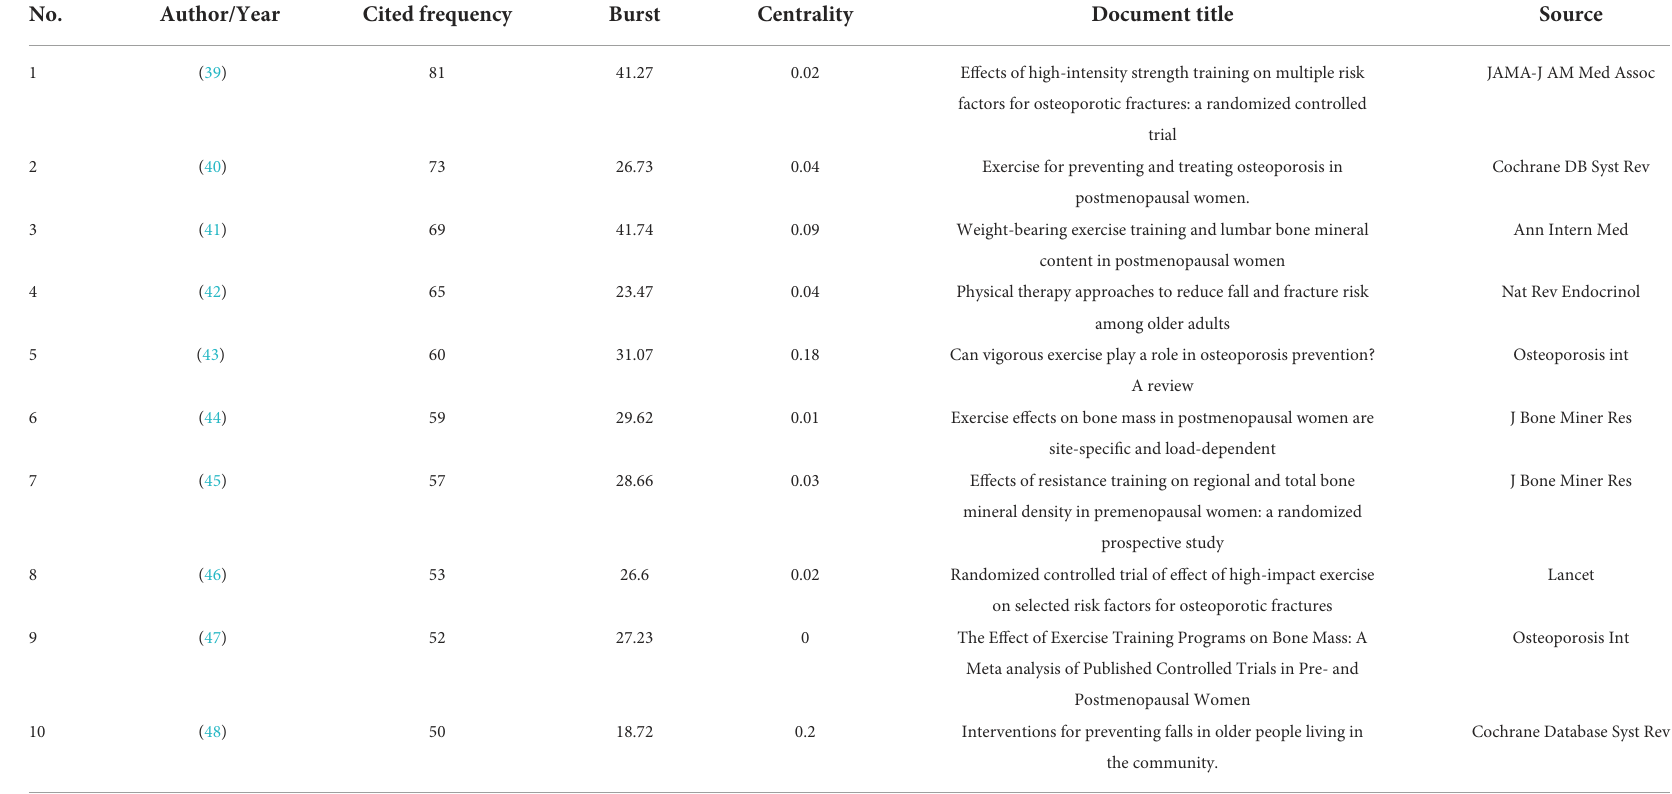
TABLE 5 The top 10 papers with the highest cited frequency and strongest citation bursts on osteoporosis rehabilitation research.